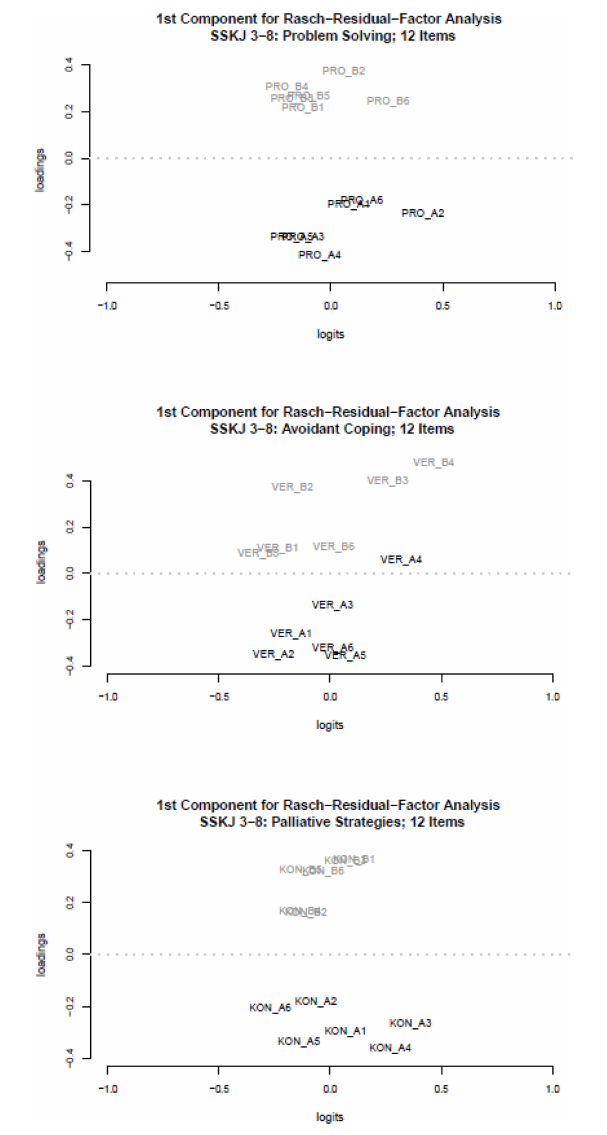
weaker and less negative than the German: “ dann raste ich total aus .”